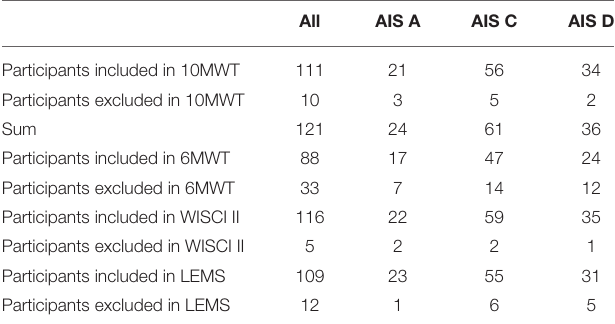
TABLE 3 | Functional tests divided according to